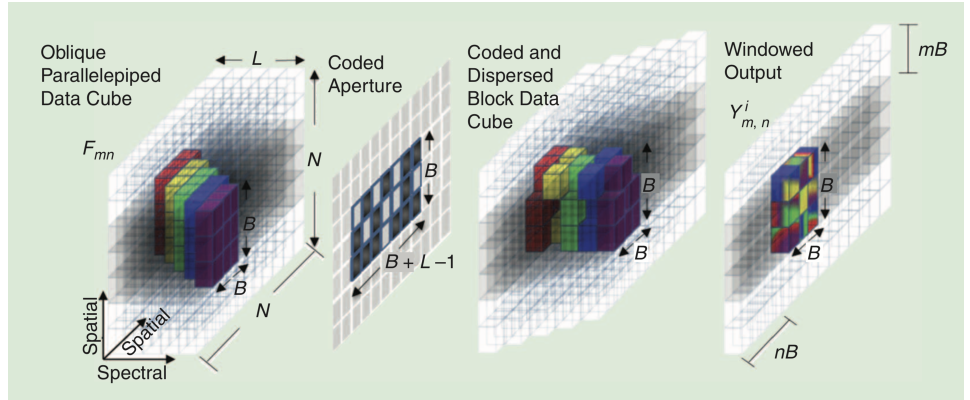
Figure 4. Graphical representation of the impact of using a block model in the CASSI procedure; reprinted from ref. [14] Copyright 2013